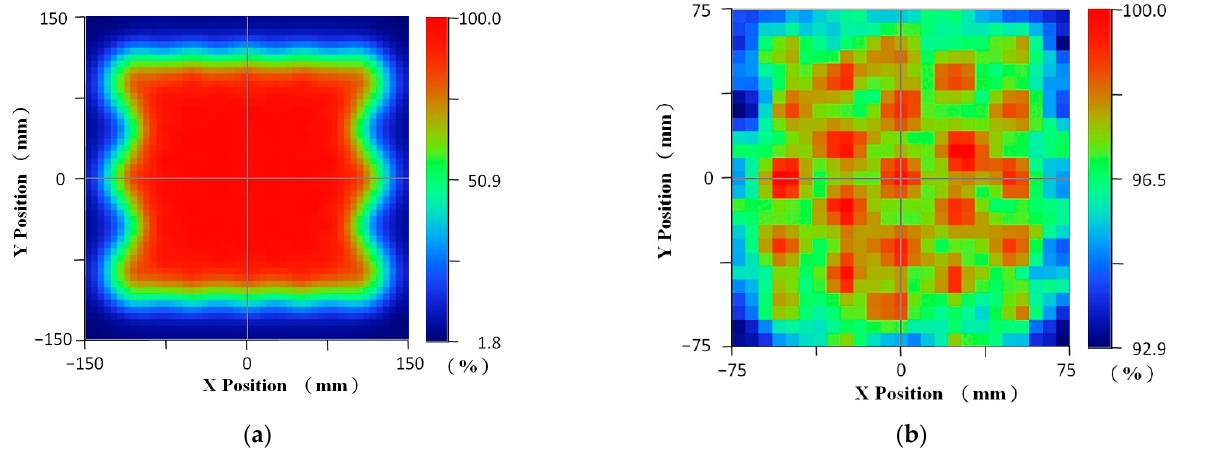
Figure 6. Irradiance distributions of the designed LPL-EM on the working plane: ( a ) irradiated region and ( b ) effective exposure region.